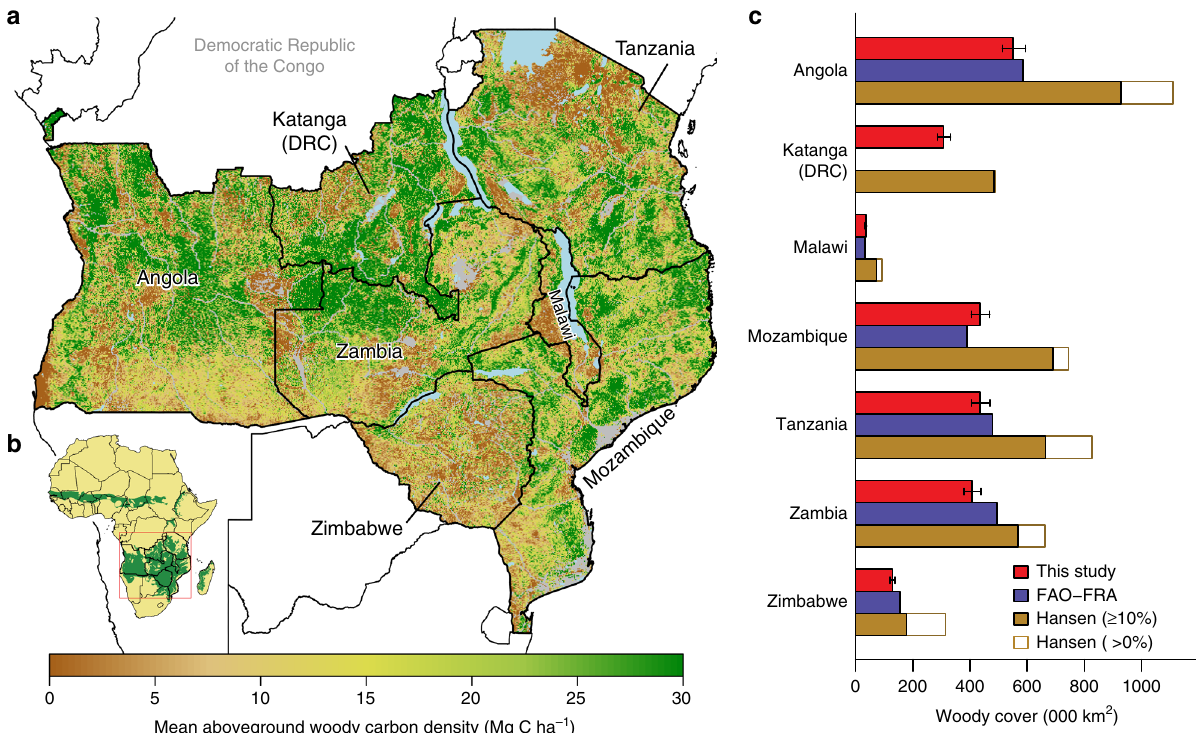
Fig. 1 Spatial distribution of aboveground woody carbon stocks in 2007, estimated from L-band radar data and in situ measurements. a The mean carbon density, averaged to 1 km 2 for display purposes, with non-wooded areas (<10MgC ha − 1 ) and other areas masked from the analysis in grey. b The location of our study region. c Wooded ( ‘ forest ’ ) area in each country according to our study, the FAO-FRA (2015) and the Hansen et al. (2013)